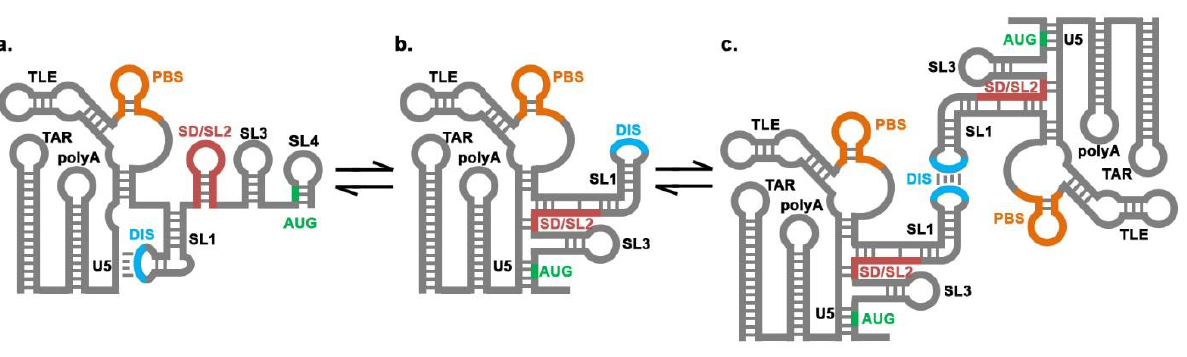
Figure 1. Proposed conformational changes of the HIV-1 5′UTR. ( a ) In the unspliced monomeric RNA, the dimerization initiation site (DIS) sequence participates in a “fold-back” interaction with the U5, thus exposing the gag start codon (AUG) for translation; ( b ) The dimerization-competent form of the RNA requires a secondary structure change in which the AUG interacts with the U5 sequence, the major splice donor site/stem-loop 2 (SD/SL2) is sequestered by base pairing with sequences in stem-loop 1 (SL1) and U5, and the DIS is exposed; ( c ) The exposed DIS in the dimerization-competent conformation is then available to form a “kissing”-loop interaction, resulting in a gRNA homodimer that is eventually stabilized into an extended dimer structure. The sequences in orange, cyan, red, and green represent the primer binding site (PBS), DIS, SD/SL2 and the AUG, respectively. In addition to primary sequence, RNA conformation has also been suggested to play a critical role in selective gRNA incorporation. The HIV-1 5′UTR has been shown to be capable of adopting multiple